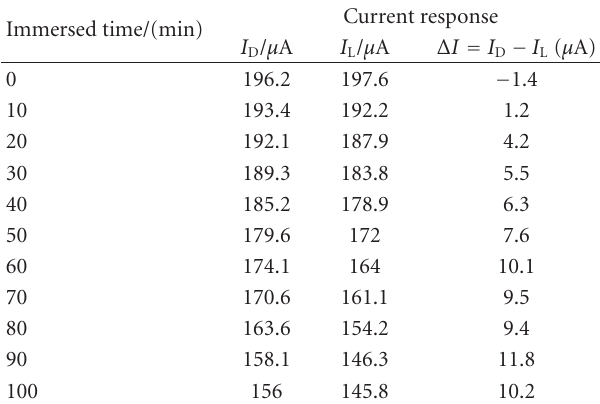
Figure 5: The relative change of oxidation current peak for di ff erent concentration Trp enantiomers adsorbed on modified electrode (a) L-Trp and (b)